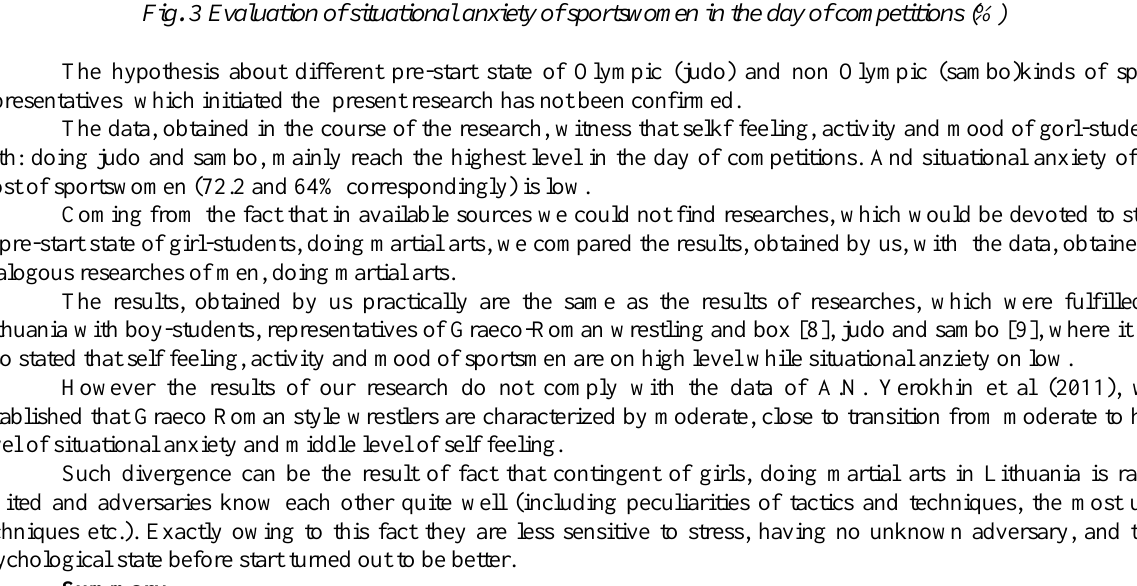
Fig. 3 Evaluation of situational anxiety of sportswomen in the day of competitions